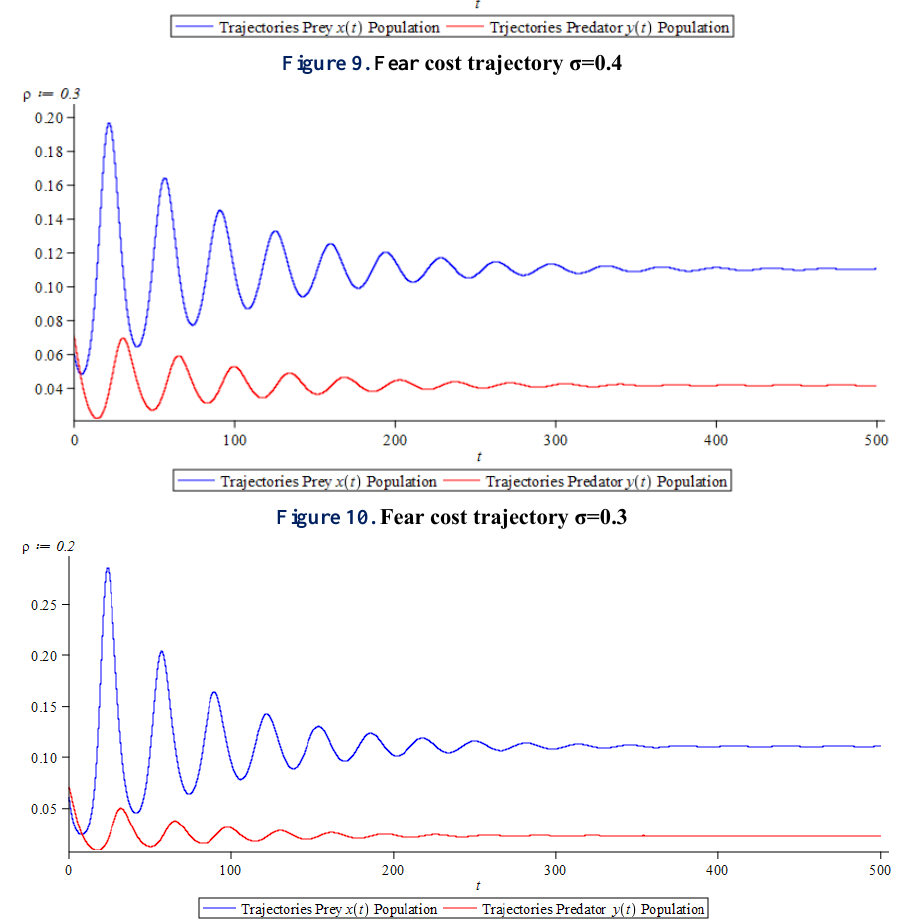
Figure 9. Fear cost trajectory σ=0.4